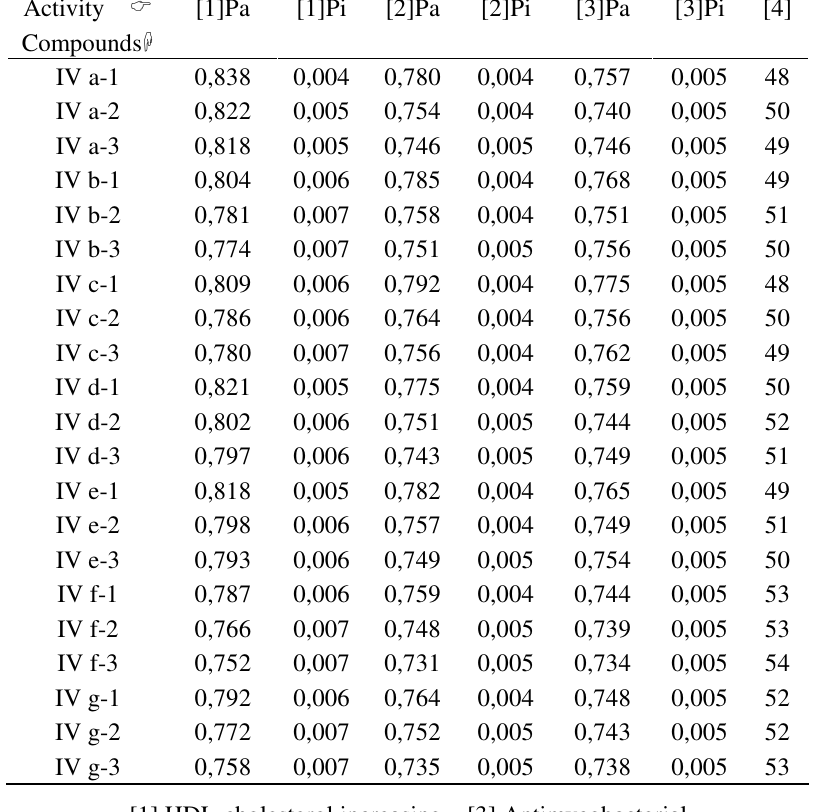
Table 11 .QSAR Analysis of Activities with Pa>70%3 Possible activities at